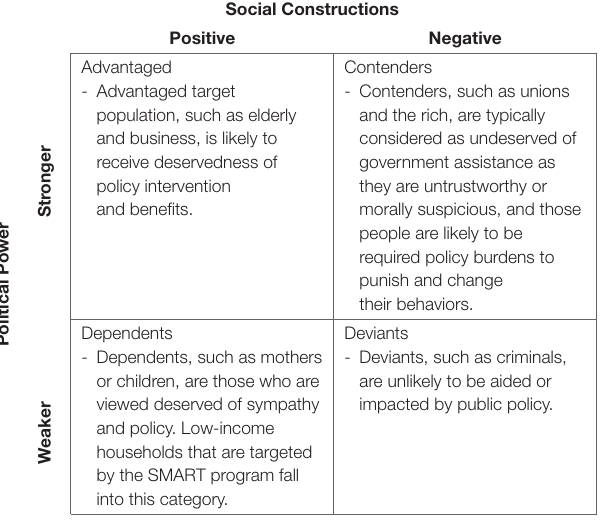
TABLE 1 | Conceptualizing target populations: social constructions and political power. Social Constructions